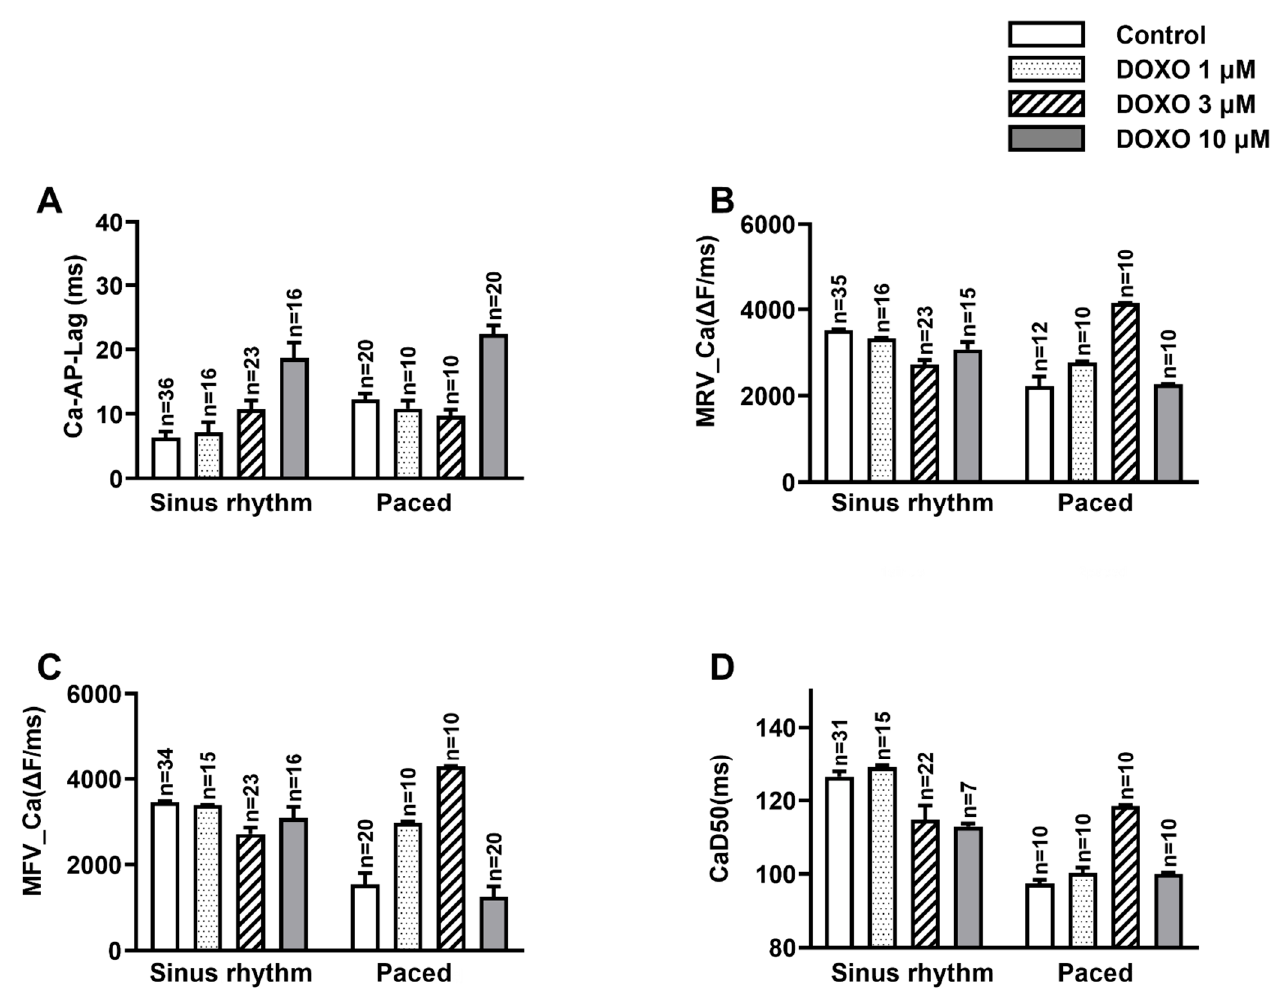
Figure 2. ( A – D ) the effect of DOXO on Ca-AP-Lag, MRV_Ca, MFV_Ca and CaD50 in sinus and tachypaced groups. ( A ) in the sinus group, 3 µ M and 10 µ M DOXO significantly prolonged the Ca-AP-Lag ( p < 0.01); in the paced group, low concentration of DOXO (1 µ M and 3 µ M) had the opposite effect to that of 10 µ M DOXO. ( B ) the MRV_Ca was decreased by DOXO (1 µ M, 10 µ M and 3 µ M, p < 0.01) in the sinus group but increased in the tachypaced group by DOXO (1 µ M and 3 µ M, p < 0.05). ( C ) the MFV_Ca was decreased by DOXO (3 µ M, p < 0.01 and 10 µ M, p < 0.05) in the sinus group, but increased by DOXO (1 µ M and 3 µ M, p < 0.01) in the tachypaced group. ( D ) The CaD50 was decreased by DOXO (3 µ M, p < 0.05 and 10 µ M, p < 0.01) in the sinus group, but was increased by DOXO (10 µ M, p < 0.01) in the tachypaced group. Ca-AP-Lag: the time difference between the peak of AP and the peak of the following Ca 2+ signal; MRV_Ca and MFV_Ca: the maximum rising and following velocity of the Ca 2+ signal; CaD50: the duration of the Ca 2+ signal at 50% of the amplitude. ∆ F: change in the fluorescence